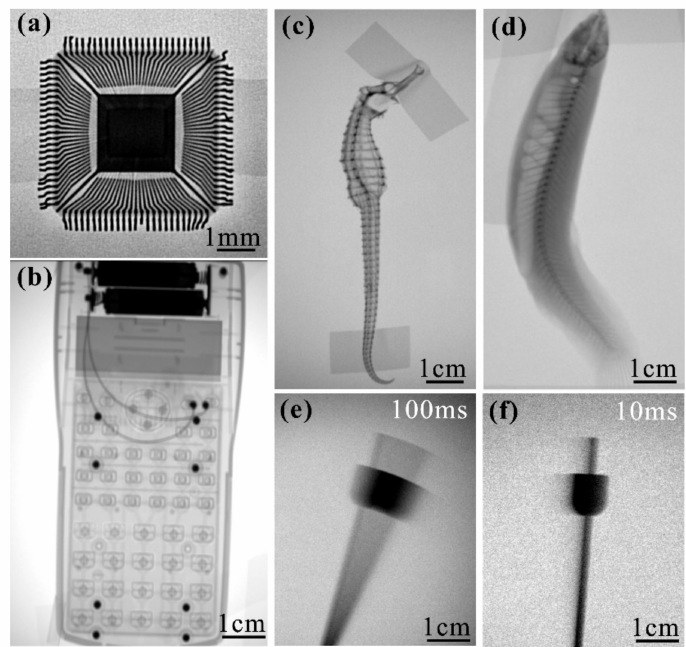
Figure 10. X-ray images of non-biological and biological samples ( a – d ). ( a ) An integrated circuit chip. ( b ) A calculator, ( c ) hippocampal specimen and ( d ) fresh loach. Images of moving metronome needle taken using the X-ray source driven using pulsed high voltage with the pulse width of 100 ms ( e ) and 10 ms ( f